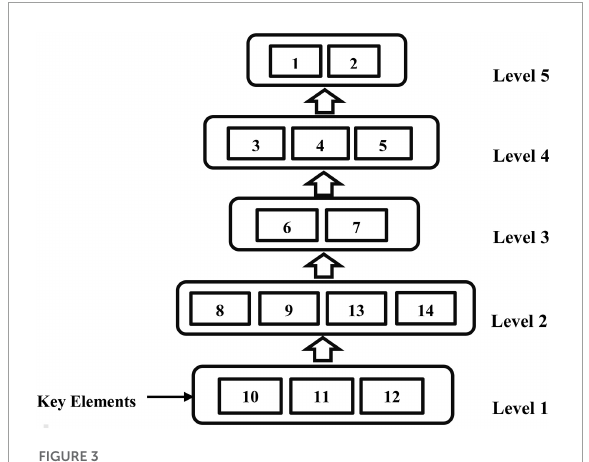
FIGURE3 Interpretive structural model (ISM) for obstacles in implementing school disaster preparedness program in Mount Sinabung